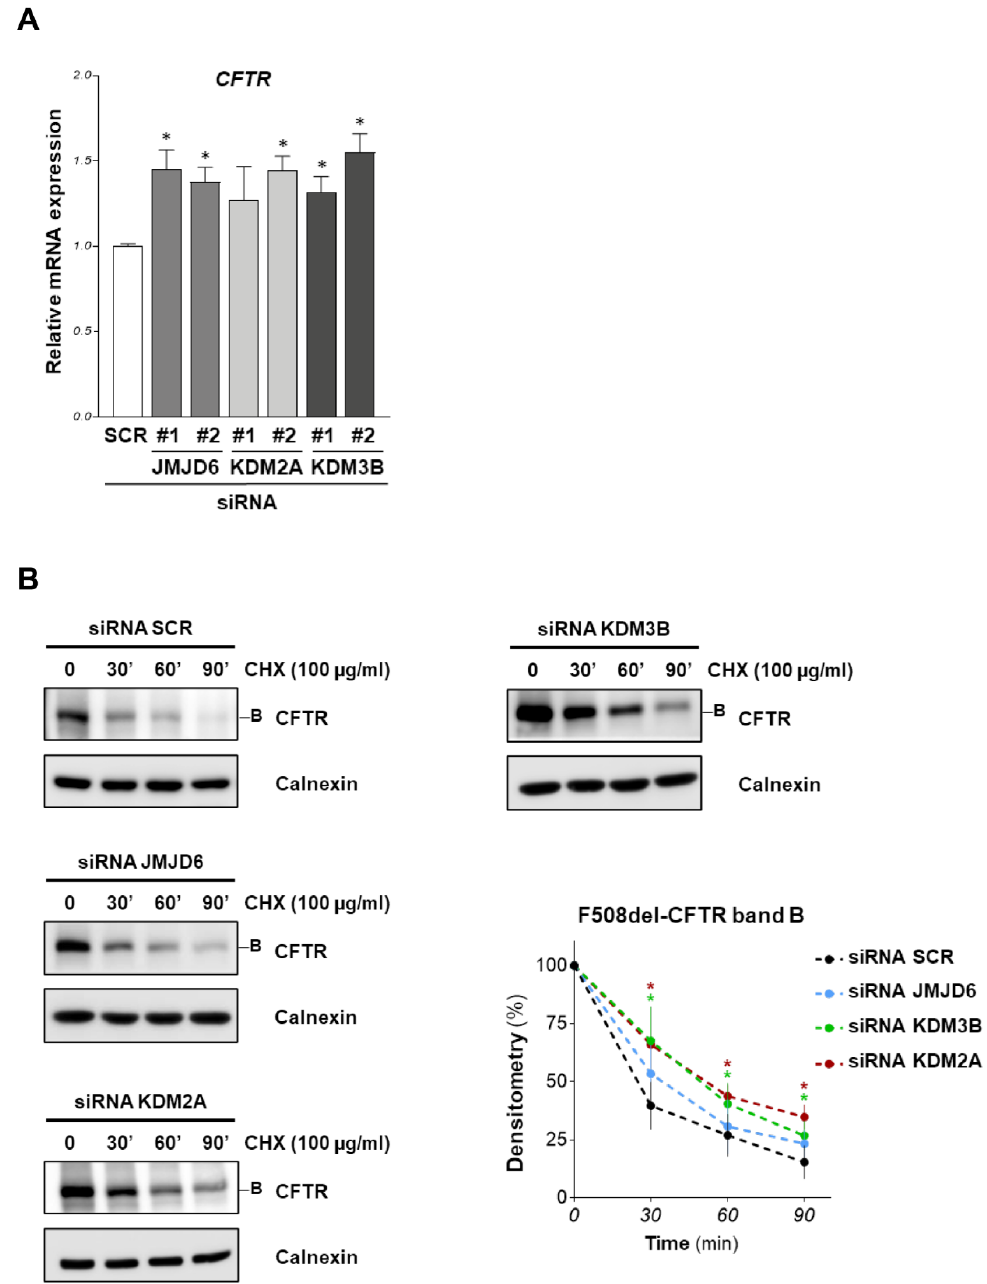
Figure 3. Transcriptional and stability analysis of F508del-CFTR after demethylases downregulation. ( A ) CFTR mRNA levels determined by quantitative real-time PCR in F508del-